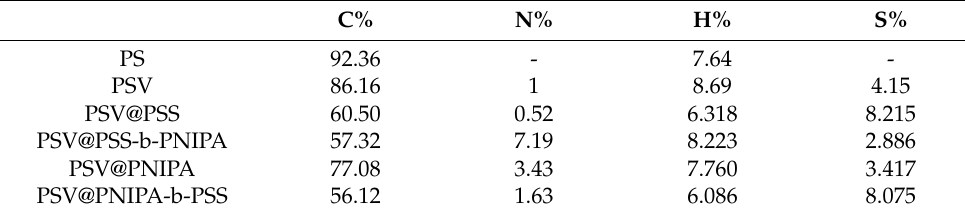
Table 1. Elemental analysis of diblock polymer